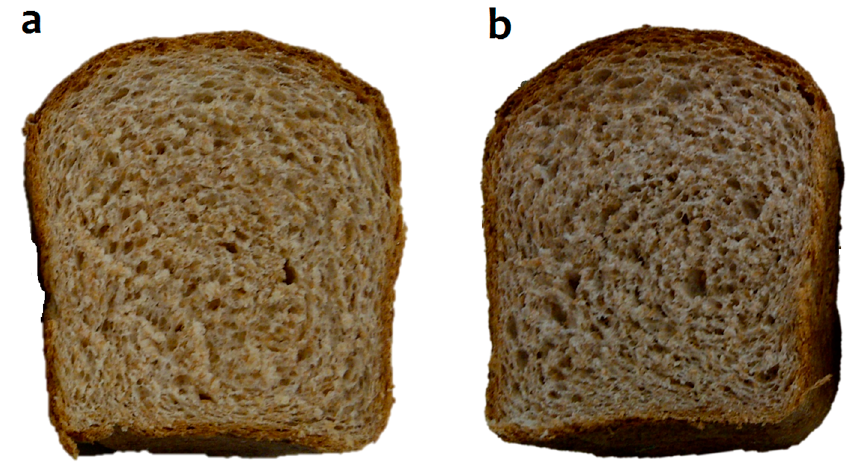
Figure 1. Appearance of ( a ) control whole wheat bread (CN); and ( b ) bread supplemented with 0.5% of black bean extract (BBE).